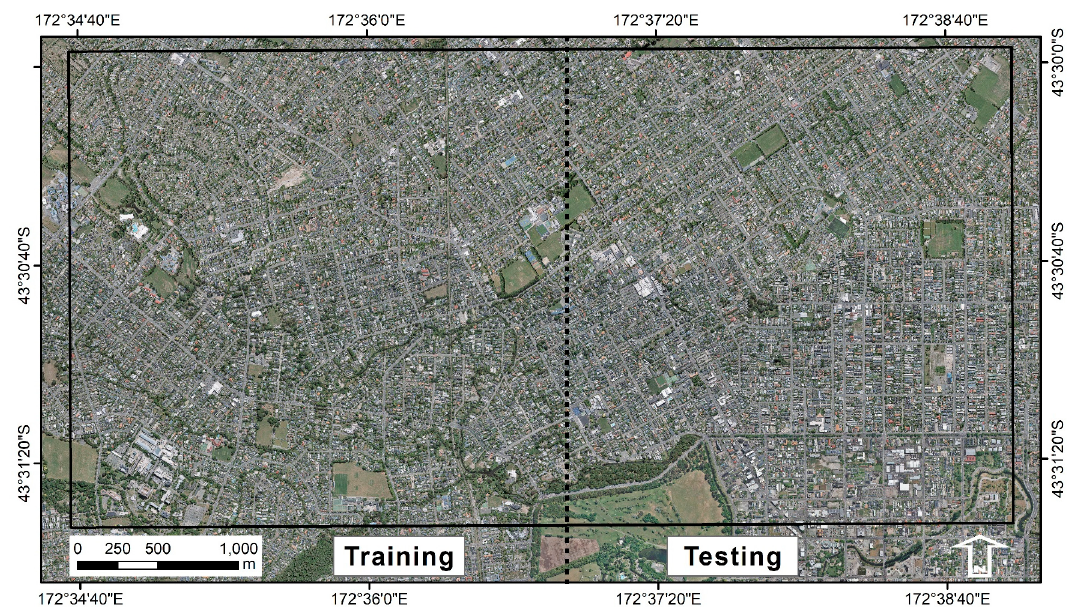
Figure 4. Overview of the dataset (an urban area of Christchurch City, New Zealand) used in the present study. The black dotted line separates the image into training and testing datasets for evaluating the performance of the proposed DeepResUnet by comparing it with other state-of-the-art deep learning